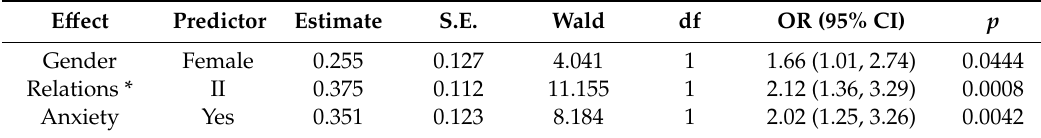
Table 8. Prediction of temporomandibular disorders (TMD) aggravation in Israel.